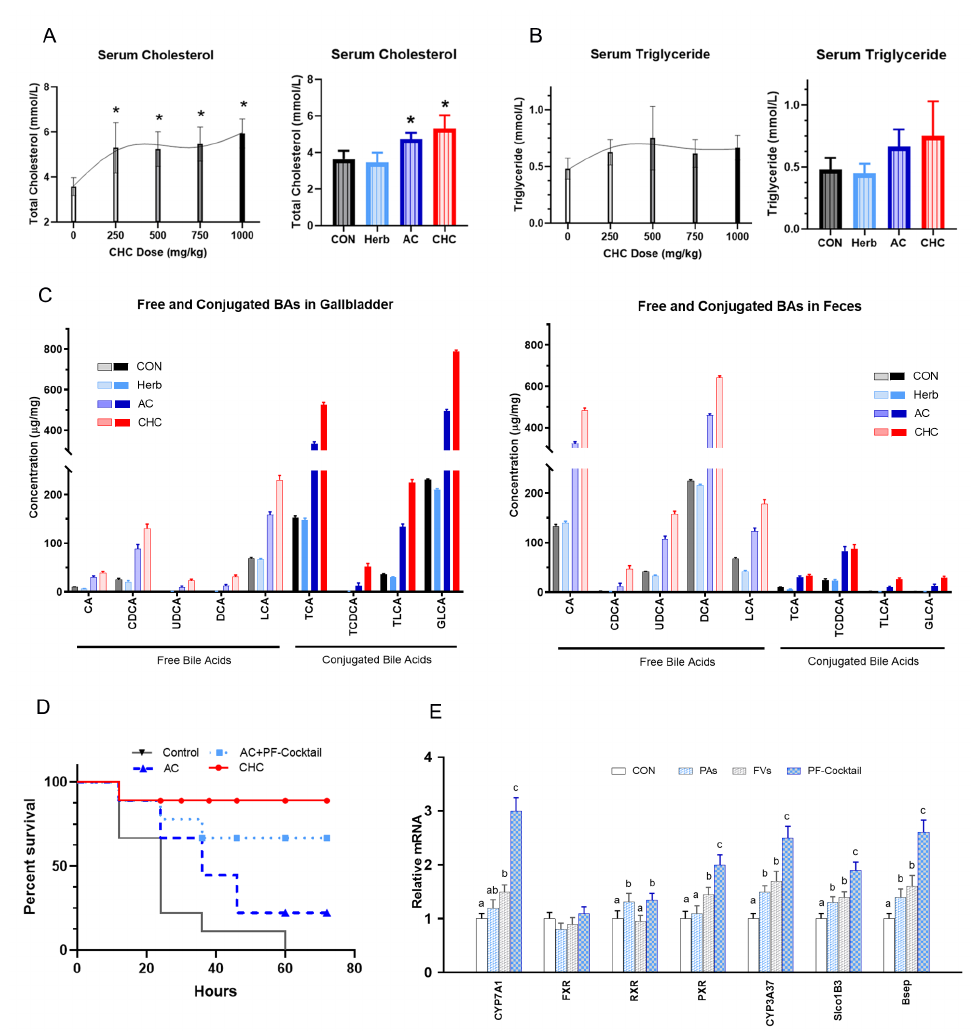
Figure 5. CHC effects on bile acid synthesis, metabolism, and alleviation of liver damage. Effects of CHC supplementation at different doses (0, 250, 500, 750, and 1000 mg/kg), of Herb (25 mg/kg), and of AC (225 mg/kg) on the levels of serum cholesterol (* indicates p < 0.05) ( A ) and triglyceride ( B ). Broilers were fed with treatment diets. CON was corn-soybean basal die. Herb, herb extracts. AC, activated charcoal. Specific bile acids in the gallbladder and feces ( C ), including free and conjugated bile acids. Survival rate of four groups of mice gavaged with AC, PF-Cocktail, and CHC upon challenge with oral T-2 mycotoxin ( D ). Male ICR mice were challenged with mycotoxin T-2 by subcutaneous injection (2 mg/kg). After 1 h, these mice were treated with gavage of saline (CON), activated charcoal (AC, 7 g/kg BW), PF-Cocktail and AC (PF-Cocktail+AC, 0.78 g/kg BW of PF-Cocktail and 7 g/g BW of activated charcoal), and CHC (7 g/kg BW), respectively. The number of surviving mice for each treatment ( n = 10) was determined at different times after exposure to T-2 mycotoxin. Survival analyses were conducted using the log-rank (Mantel–Cox) test in GraphPad Prism 7. Treatments with phenolic acids (PAs), flavonoids (FVs) or PF-Cocktail altered the expres- sion of xenobiotic detoxification enzymes in broiler primary hepatocytes ( E ). The mRNA levels of metabolic enzymes and nuclear receptors involved in bile synthesis, metabolism, and xenobiotic detoxification ( CYP7A1, FXR, RXR, PXR, CYP3A37, Slco1B3, and Bsep ) in cultured primary chicken hepatocytes were quantified by qRT-PCR, with GAPDH mRNA as an internal control. PAs (phenolic acids, composed of caffeic acid and vanillin at a ratio of 1:1, w / w , 150 µ g/mL); FVs (flavonoids, composed of daidzein and quercetin-D-glucoside at a ratio of 1:1, w / w , 50 µ g/mL); PF-Cocktail (PAs+FVs, 200 µ g/mL). One-way ANOVA was performed for statistical analysis. Bars with different letters indicate significant differences within a quantified gene ( p <